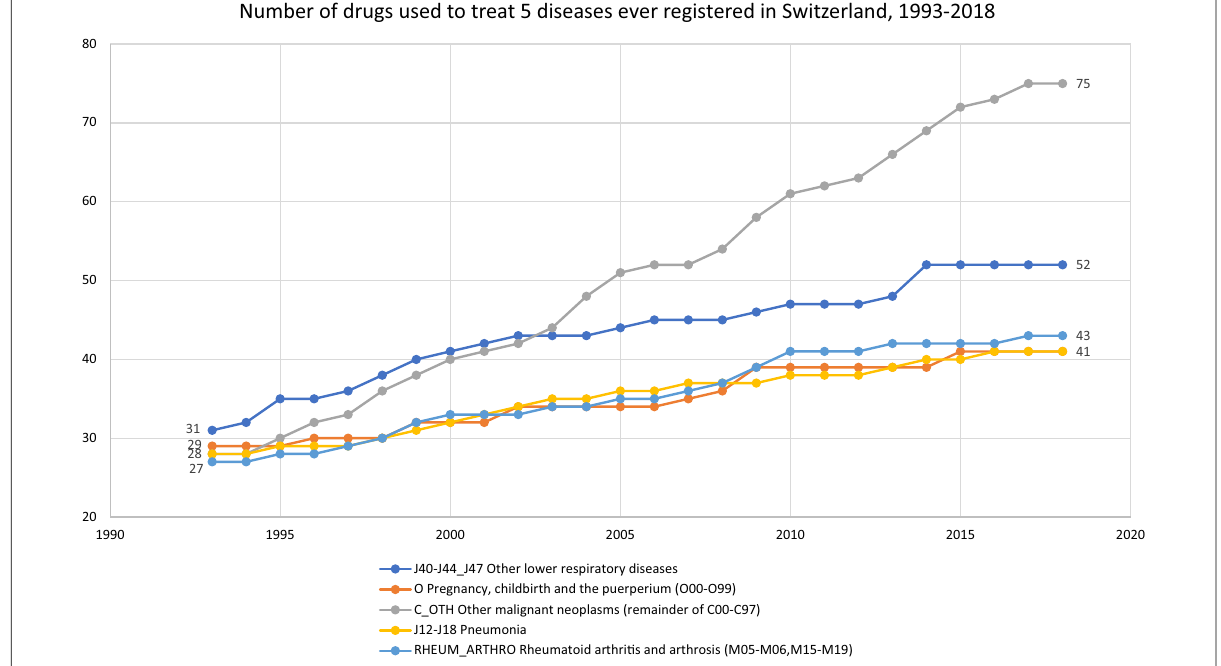
Fig. 1 Number of drugs used to treat 5 diseases ever registered in Switzerland, 1993–2018. Source : Author’s calculations based on data contained in Swissmedic’s Extended list of medicines and Centre National Hospitalier d’Information sur le Médicament’s Thériaque